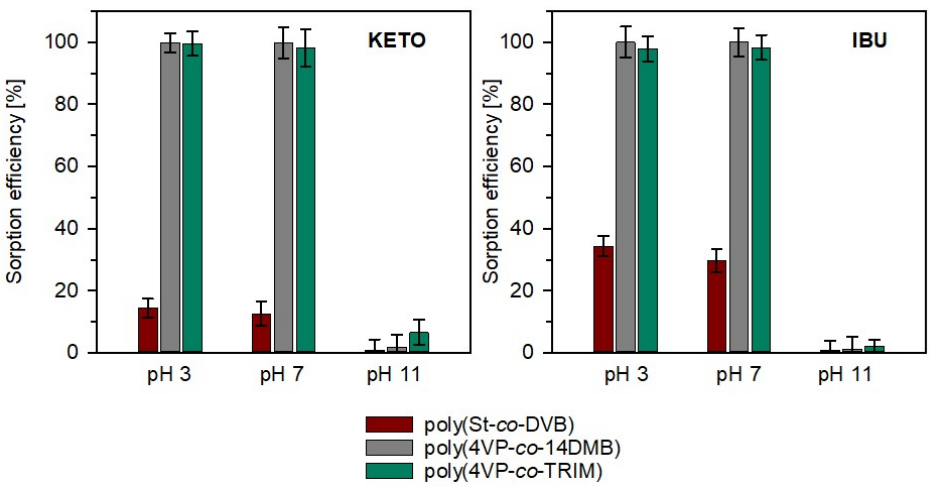
Figure 7. Sorption efficiency of ketoprofen (KETO) and ibuprofen (IBU) on studied copolymers in pH 3, 7, 11; (mean (bar) ± standard deviation (whisker) ( n =